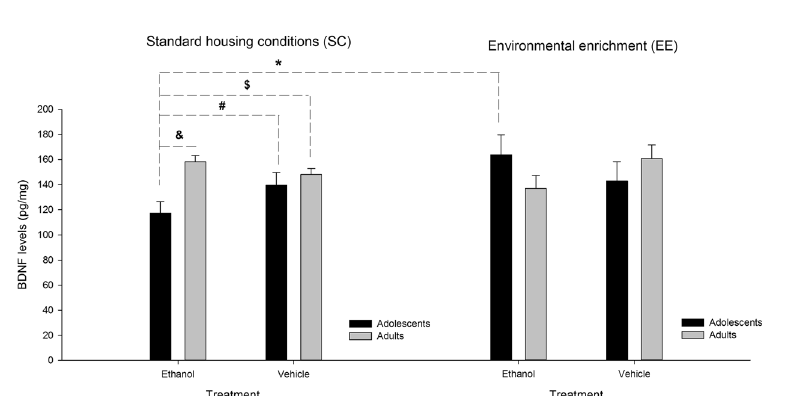
Figure 4. Brain-derived neurotrophic factor (BDNF) levels in prefrontal cortex of adolescent and adult male Swiss mice as a function of rearing condition (standard [control] conditions and environmental enrichment) and treatment (4, every-other-day administrations of 0.0 [vehicle control] or 2.0 g/kg ethanol). The adolescent group treated with ethanol and exposed to standard (control) rearing conditions (first black bar on the left) exhibited significantly less BDNF levels than ( A ) any of the other groups (adolescents or adults) reared under standard housing conditions and treated with vehicle [these significant differences are indicated by the pound (#) and currency ($) signs, respectively], ( B ) the adults treated with ethanol and exposed to standard (control) rearing conditions [a significant difference indicated by the ampersand (&) sign] and C ) adolescents reared under environmental enrichment conditions and treated with ethanol. The latter significant difference is are indicated by the asterisk ( * ) sign. Values express mean ±